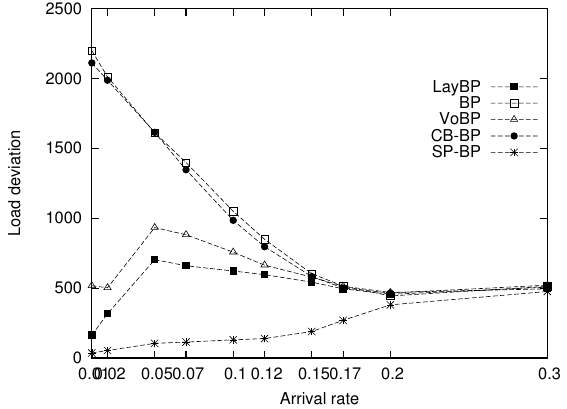
Figure 11. Load deviation for the grid network topology